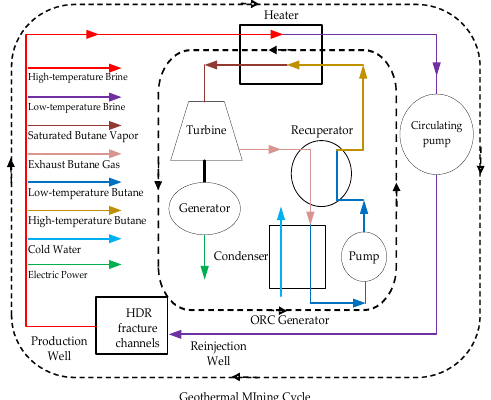
Figure 2. Structure chart of the hot dry rock ( HDR) power station.